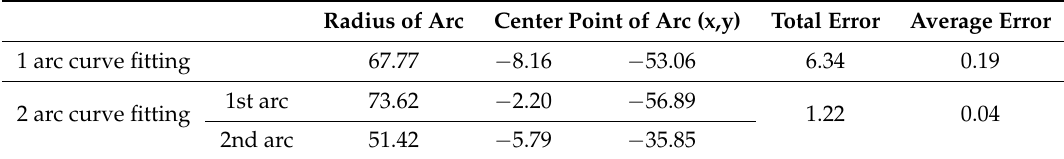
Table 1. Piecewise arc curve fitting results